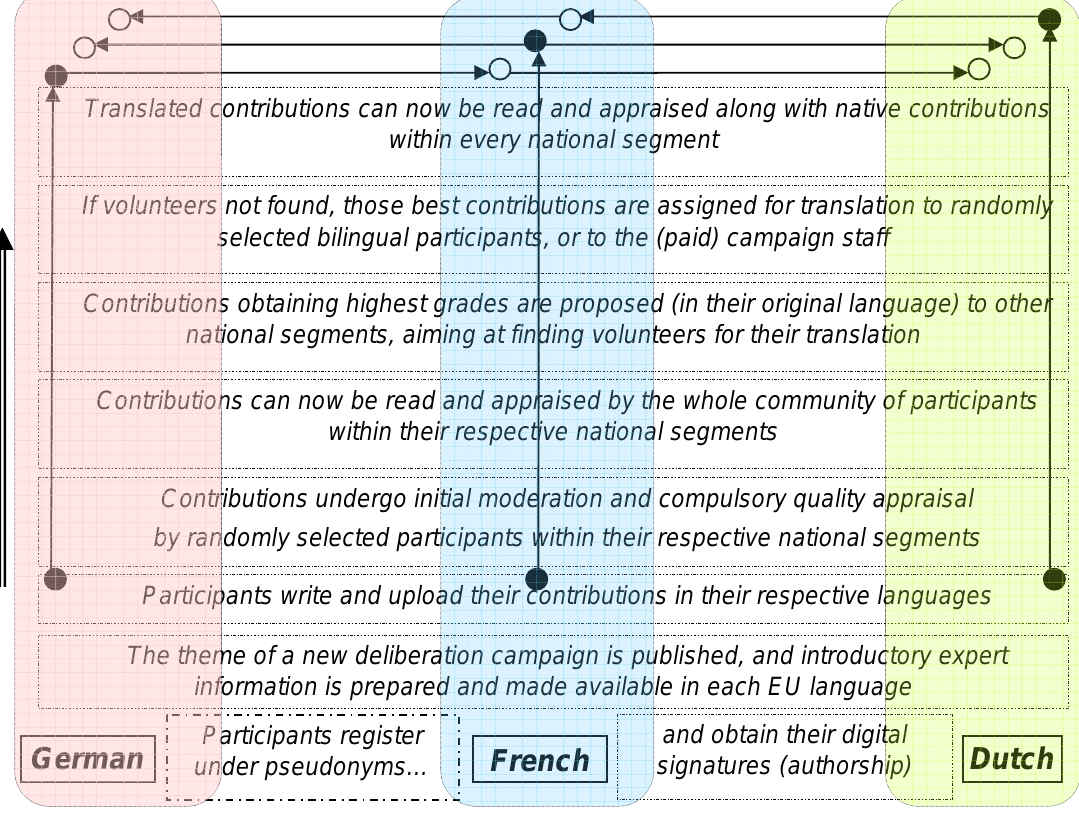
Figure 1: Cross-language flow of